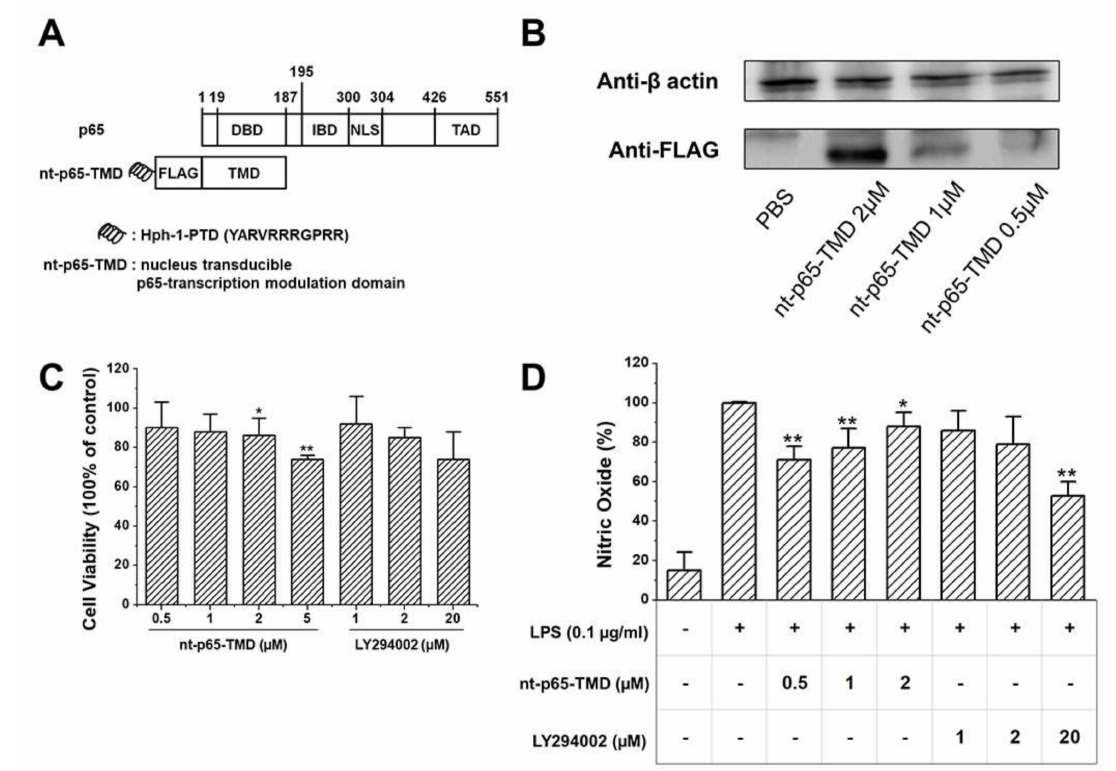
Figure 1. ( A ) Structure of nt-p65-TMD. ( B ) Transduction efficiency of nt-p65-TMD. Dose-dependent intracellular transduc- tion efficiency of nt-p65-TMD into RAW264.7 cells. nt-p65-TMD was detected by immunoblot analysis with anti-FLAG antibody. β -actin was used as loading control. ( C ) Cell viability of nt-p65-TMD in RAW264.7 cells. Cells were treated with different concentrations of nt-p65-TMD for 24 h, and cell viability was assessed using CCK-8 assay kit. LY294002 treatment groups were considered positive controls. The data are expressed as mean ± standard deviation. Cell viability differed significantly for the 2 and 5 µ M nt-p65-TMD treatment groups compared to the control group. Data show mean ± standard deviation values of three independent experiments. * p < 0.05 and ** p < 0.01 indicate significant differences compared to the control value (100%). ( D ) NO release of nt-p65-TMD in RAW264.7 cells. Cells were incubated in the presence of different concentrations of nt-p65-TMD and 0.1 µ g/mL LPS for 20 h. Then, the culture supernatant was analyzed for NO. Data show mean ± standard deviation values of three independent experiments. * p < 0.05 and ** p < 0.01 indicate significant differences compared to LPS-stimulation value